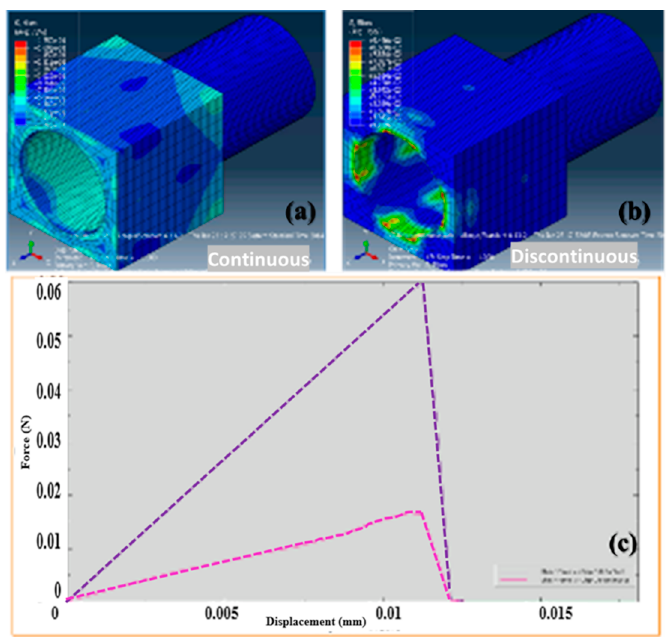
Figure 3. ( a ) Stress plot for continuous interface coating on the fiber, ( b ) stress plot for discontinuous interface coating on the fiber, and ( c ) force-displacement plot for the simulated fiber pull-out where force is measured in (N) and displacement in (mm).